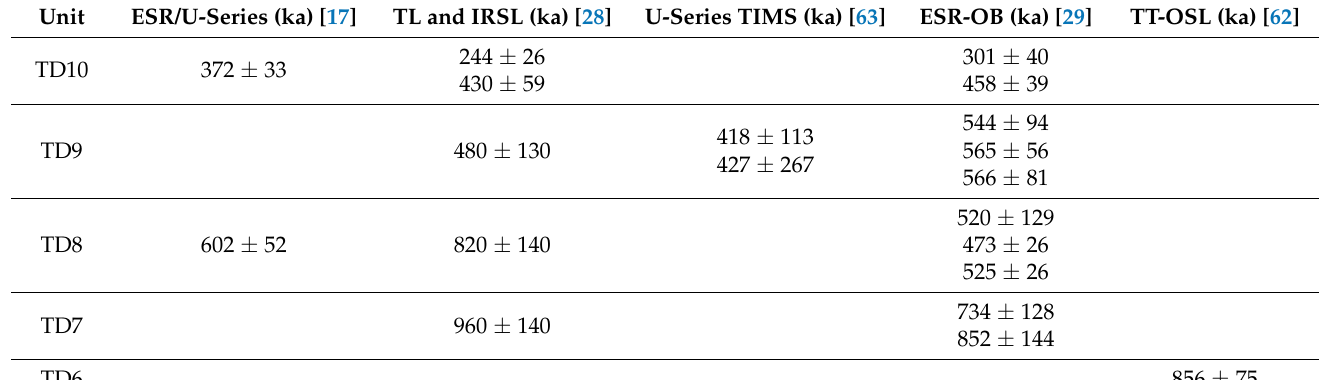
Table 5. Datation of upper sedimentary infill of the Gran Dolina cave obtained by different methods. TL and IRSL (ka)